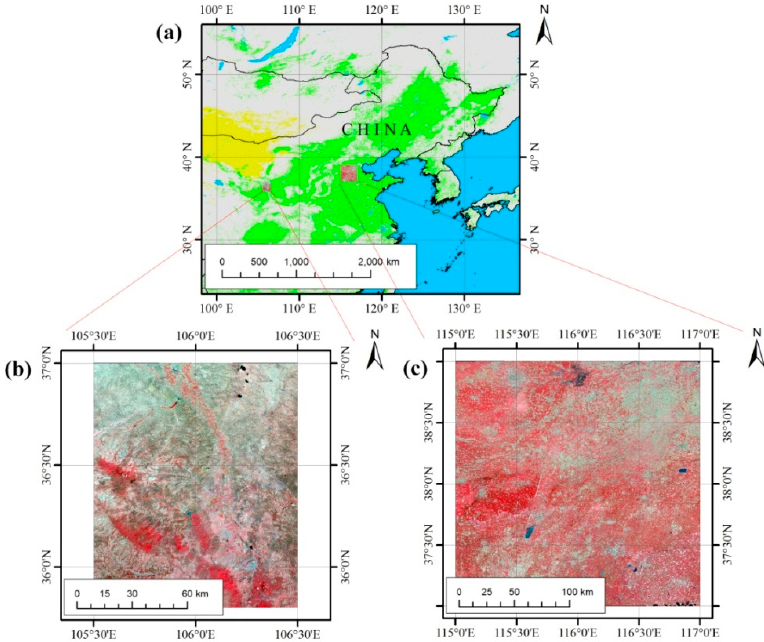
Figure 1. Study regions. ( a ) Location of the two study regions, ( b ) false color image of Guyuan (GY, 15-day Sentinel-2 composited image between 1 and 15 June), ( c ) false color image of Hengshui (HS, 15-day Sentinel-2 composited image between 1 and 15 July).